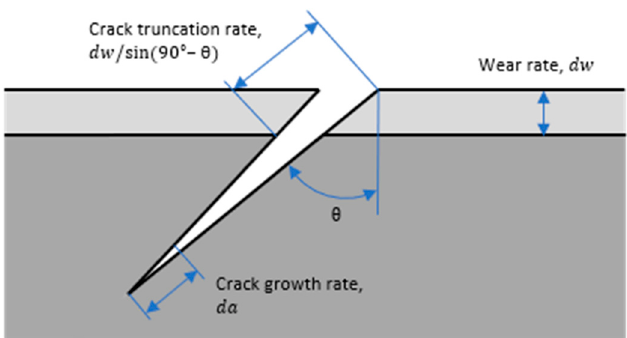
Figure 5. Net Crack considering crack growth and rail wear. Adapted from [21].